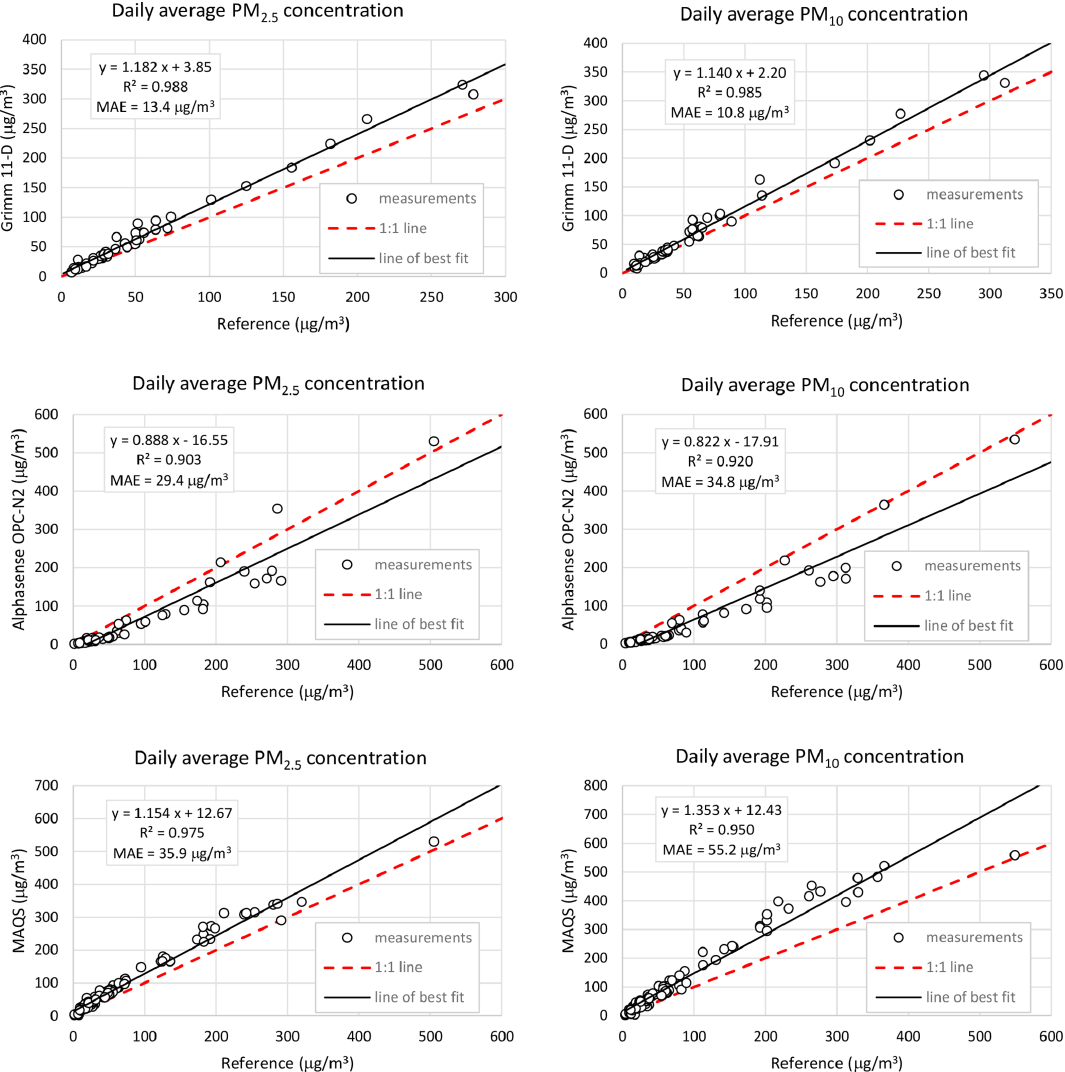
Figure 5. OPS performance during the period of strong pollution (2 December 2019–12 March